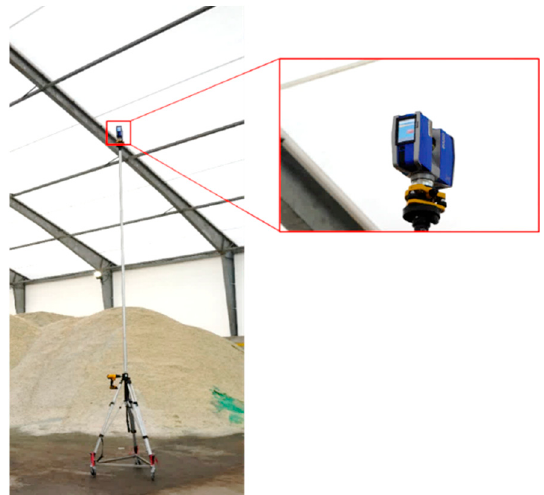
Figure 25. FARO Focus on an extendable tripod inside the Lebanon Facility.